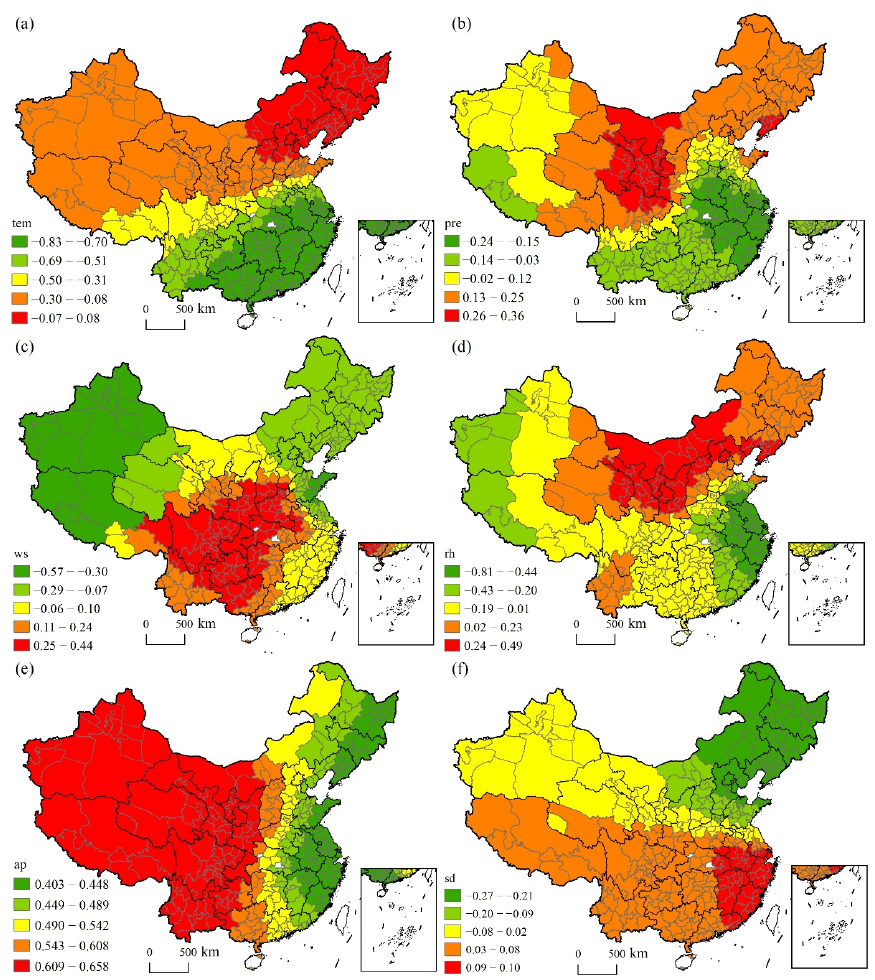
Figure 7. Spatial heterogeneous effects of natural factors: ( a ) temperature, ( b ) precipitation, ( c ) wind speed, ( d ) relative humidity, ( e ) air pressure and ( f ) sunshine duration.